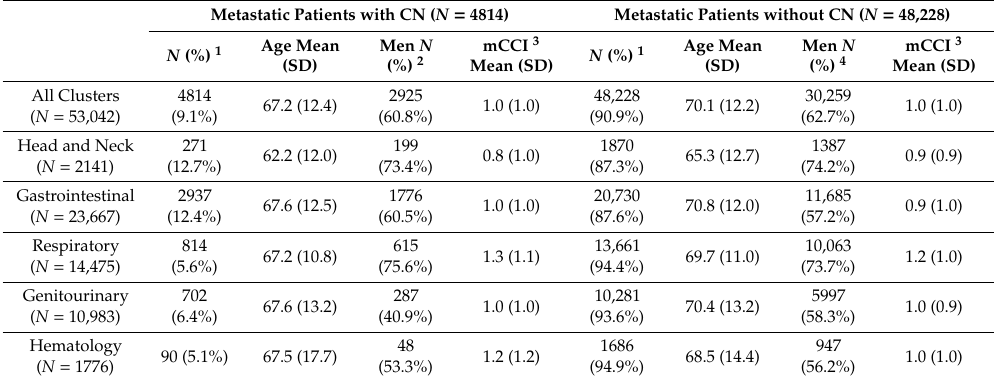
Table 1. Characteristics of metastatic patients according to cancer site and stratified by presence / absence of clinical nutrition.